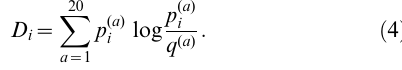
Figure 5. A) PCA of the correlation matrix produced by (left) w var and M alignment. B) Residues identified by w cons and SCA the calcium binding site; calcium ions colored yellow [29].